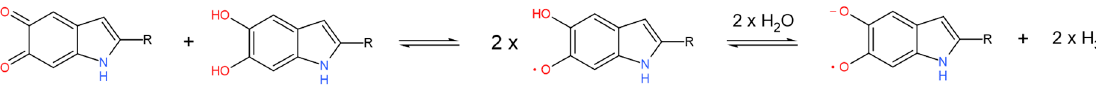
Figure 2. The comproportionation reaction, where the oxidized form (quinone I , or quinone methide II , or quinone imine III ) and the reduced form (quinol VII ) of the moieties leads to the formation of the intermediate oxidation form, the radical semiquinone ( IV or VI ). In the solid state, hydration leads to deprotonation of semiquinone to form the semiquinone anion ( V or VII ) and mobile proton species, traditionally signified on schemes by hydronium cations H 3 O + .